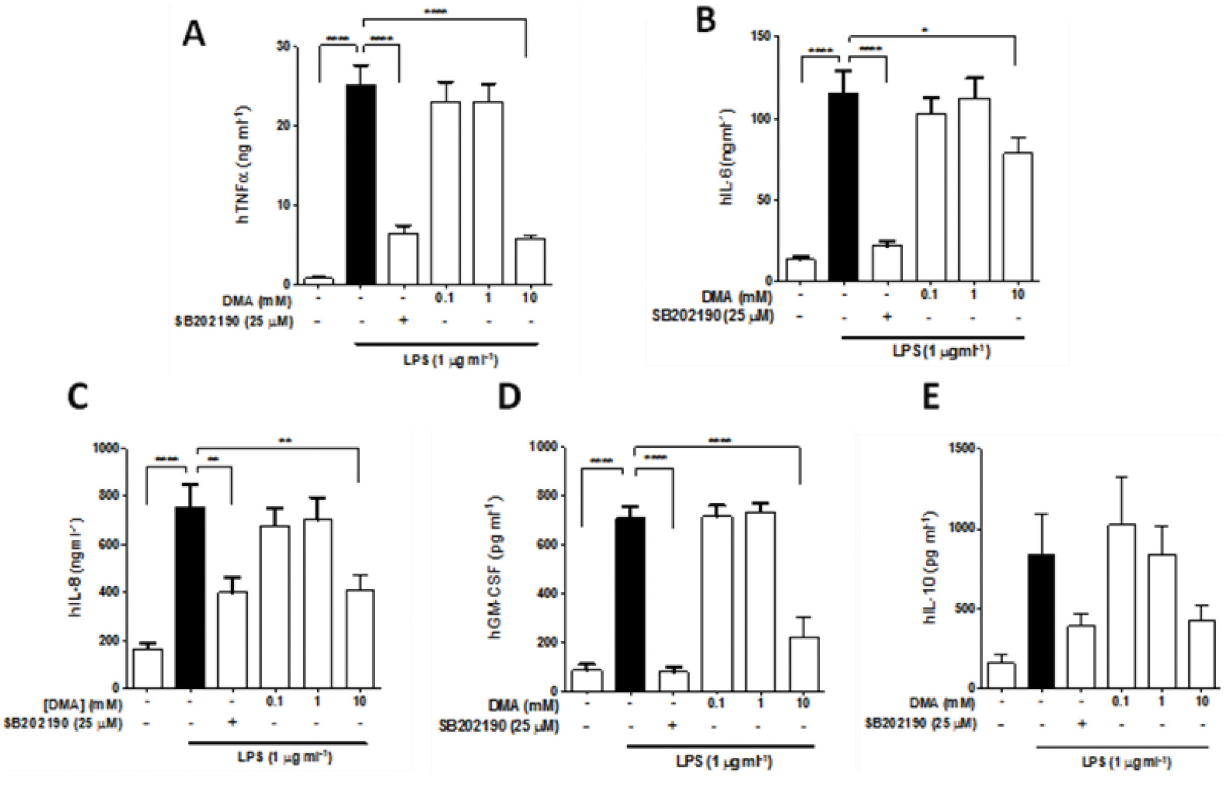
Figure 4. DMA inhibits cytokine and chemokine secretion in LPS-stimulated human placental explants. ELISA was performed to determine levels of (A) TNF α , (B) IL-6, (C) IL-10, (D) IL-8 and (E) GM-CSF after incubation with DMA or SB 202190 in the presence of LPS after 20 h. Data shown are means ± SEM of experiments done in duplicate ( n = 7). * P ≤ 0.05; ** P ≤ 0.01; *** P ≤ 0.001; **** P ≤ 0.0001.